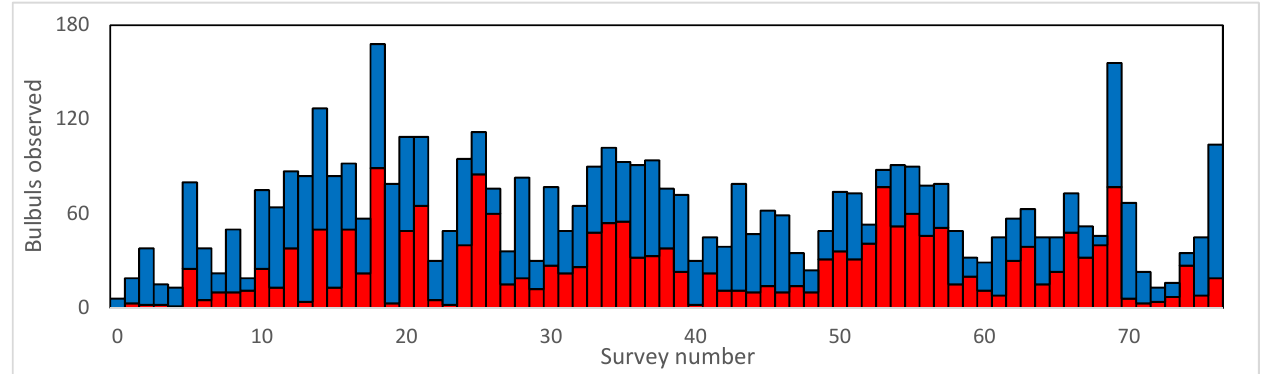
Figure 3. Numbers of orange-spotted bulbul Pycnonotus bimaculatus (red bars) and yellow-fronted bulbuls P. goiavier (blue bars) recorded openly offered for sale in 76 fortnightly surveys (August 2016 to October 2019) at Kerkhof wildlife market in Garut, West Java, showing substantial variations in